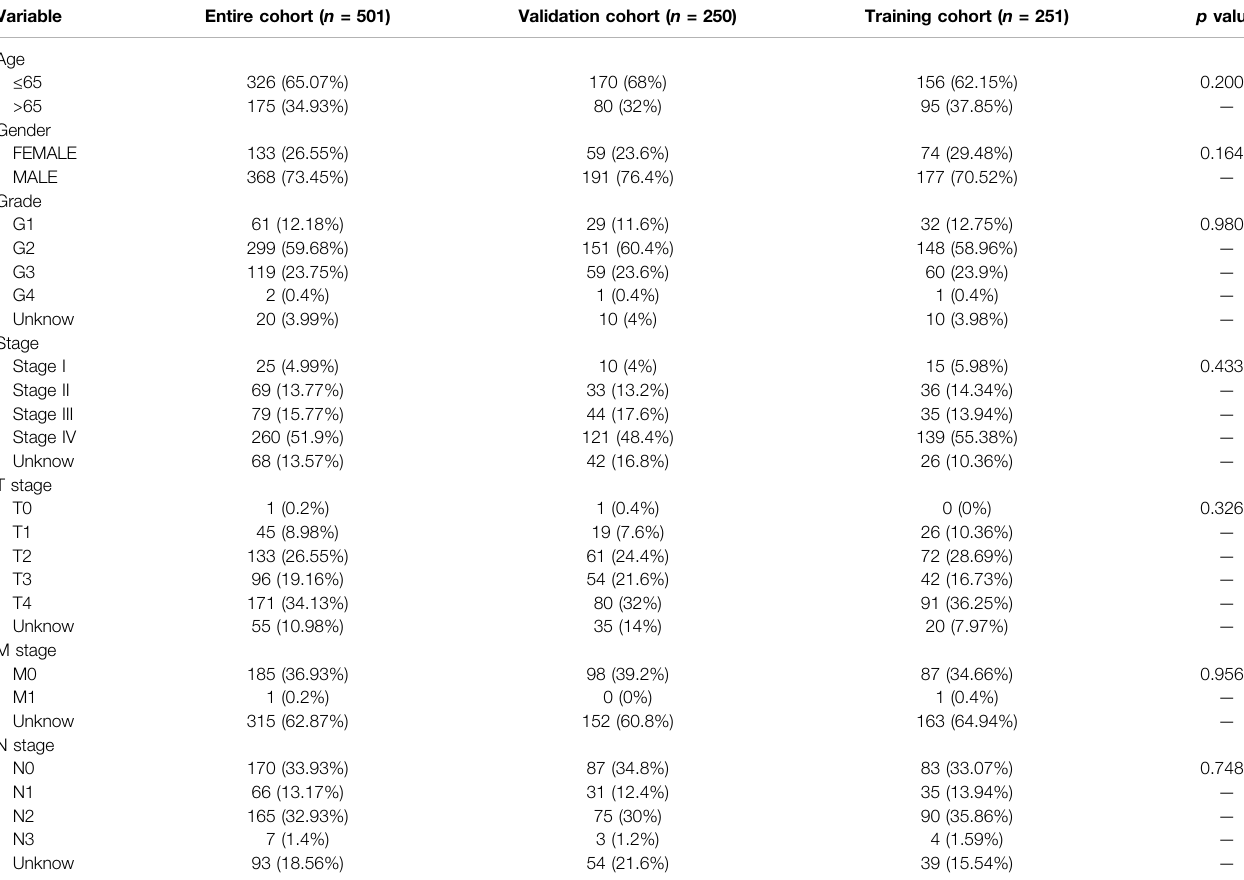
TABLE 1 | Characteristic of head and neck squamous cell carcinoma patients.